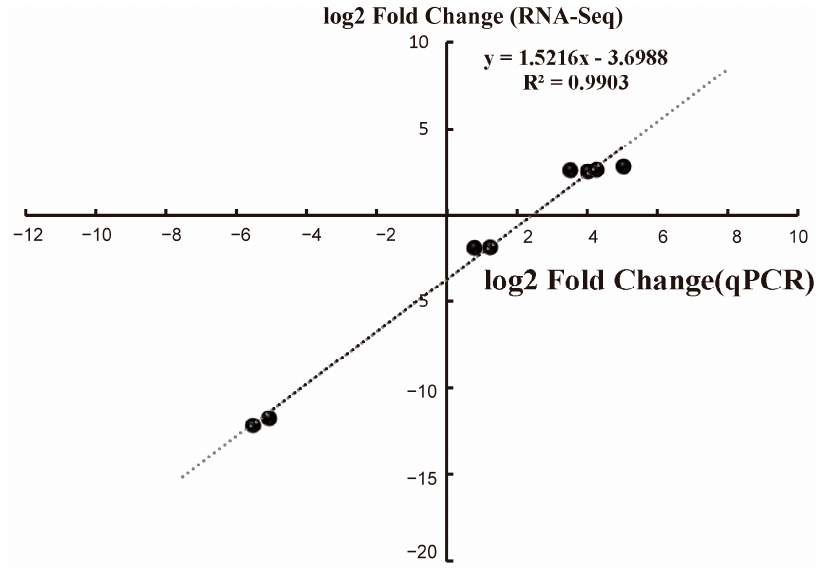
Figure 6. RT-qPCR validation of RNA-Seq results for the ML treatment groups. Three biological replicates were performed for each group. The horizontal coordinate is the log2 Fold Change value obtained from qPCR data and the vertical coordinate is the log2 Fold Change value obtained from RNA-Seq data.